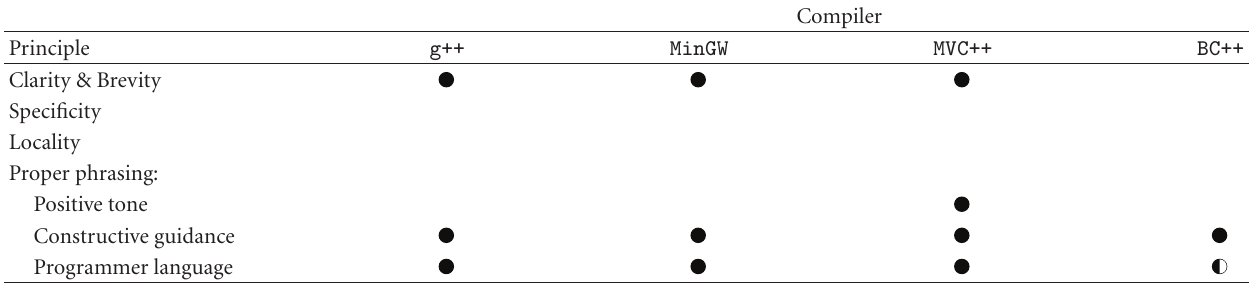
Table 10: Which principles are violated by which compilers for Error message 6.